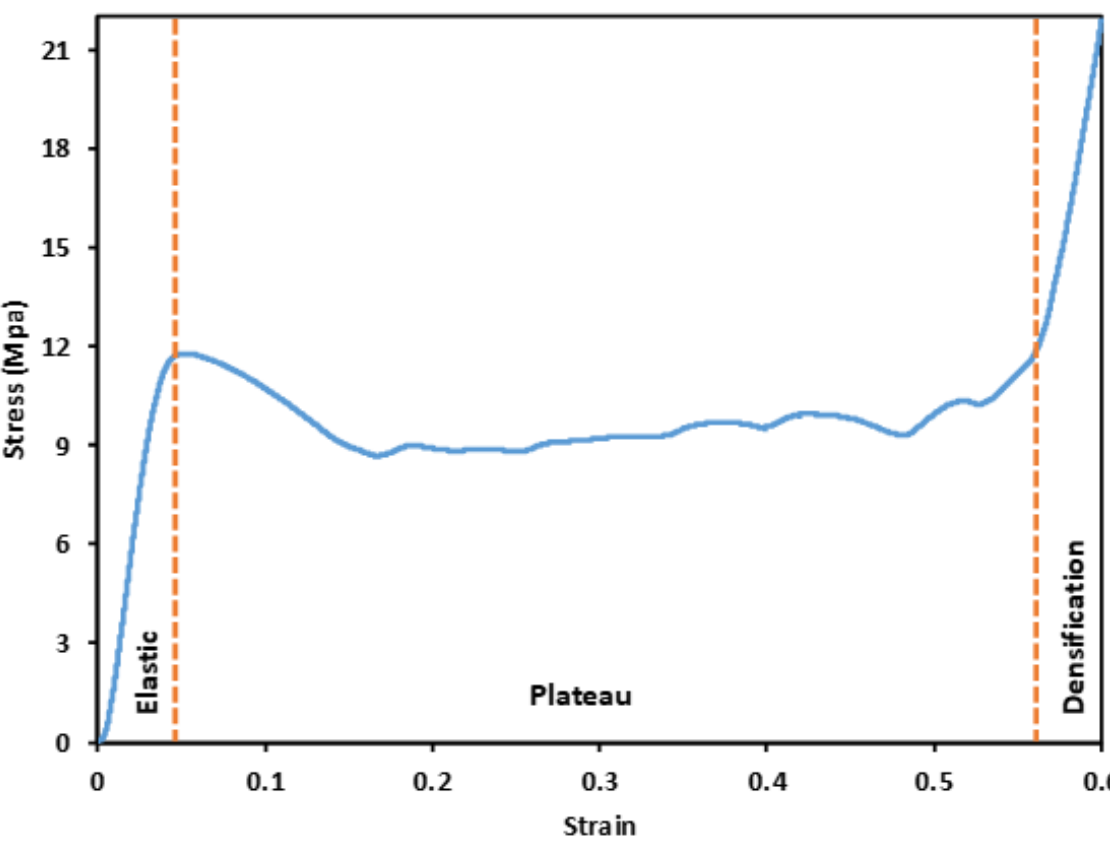
Figure 7. Typical compression behavior of a lattice structure; P-8-44 structure as an example.